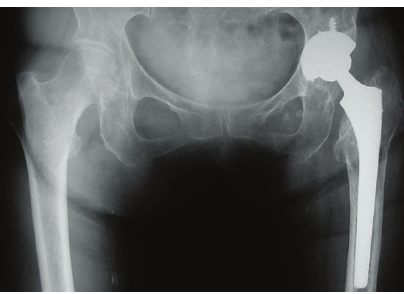
Figure 5: There is no loosening of the acetabular component at three years after revision